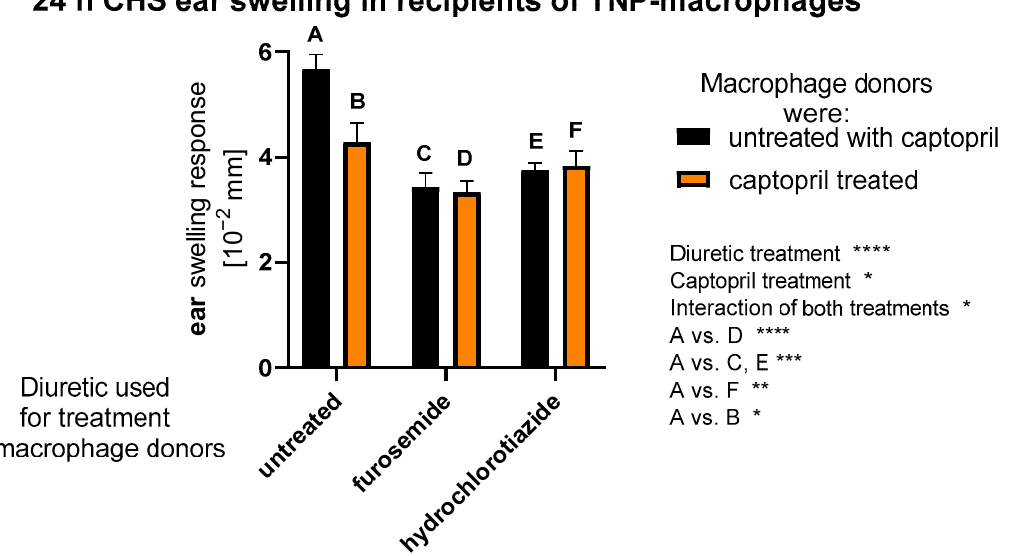
Figure 1. CHS reaction in mouse recipient of TNP-conjugated macrophages obtained from drug- treated mice. Donors of peritoneal macrophages were treated intraperitoneally with captopril with or without furosemide or hydrochlorothiazide for eight consecutive days. Then, oil-induced macrophages were harvested and conjugated with TNP hapten for 10 min in darkness at room tem- perature. After washing, TNP-conjugated macrophages were adoptively transferred by intravenous injection into naive recipients. A week later, TNP-macrophage recipients were challenged with a 0.4% PCL to elicit CHS ear swelling, measured with engineer’s micrometer 24 h later. The averaged results of ear-thickness increase, after subtracting the ear thickness increase in non-sensitized but challenged littermate mice, were expressed as delta +/ − standard error of the mean. Two-way ANOVA with Tukey’s post hoc test. * p < 0.05; ** p < 0.01; *** p < 0.005; **** p < 0.001, macrophage donors: n = 3 (in each group), macrophage recipients: n = 4 (in each drug-treated mice test group) + negative control n = 3; N = 2.